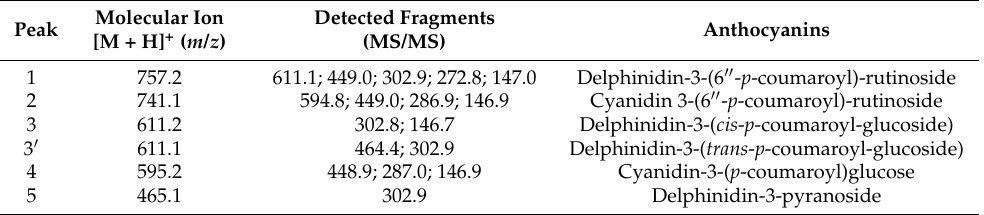
Table 2. Anthocyanin compounds identified in butterfly pea flower.